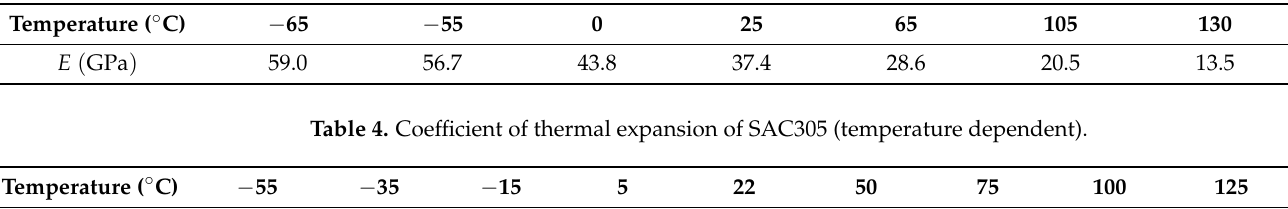
Table 3. Elastic modulus of SAC305 (temperature dependent).